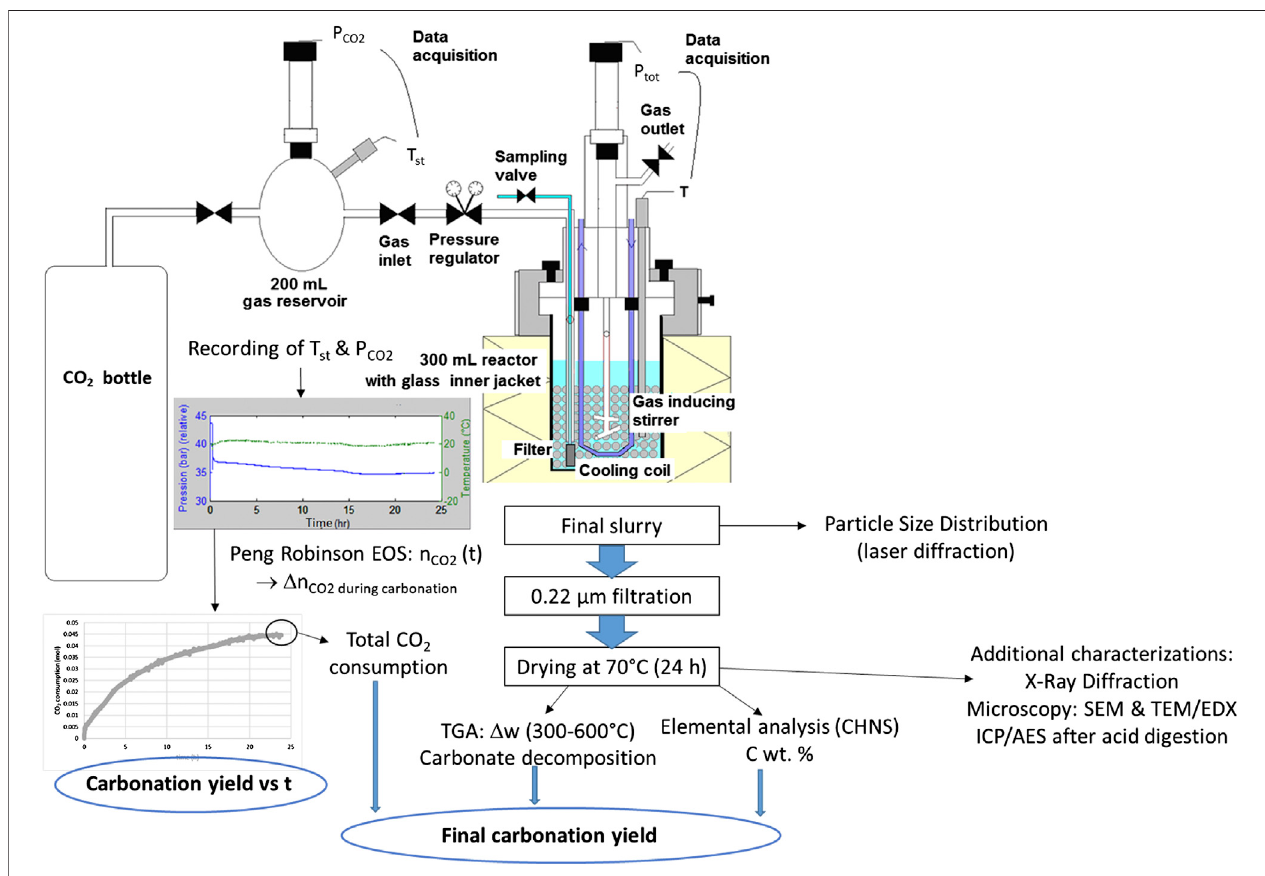
FIGURE 4 | Schematics of the experimental set-up and